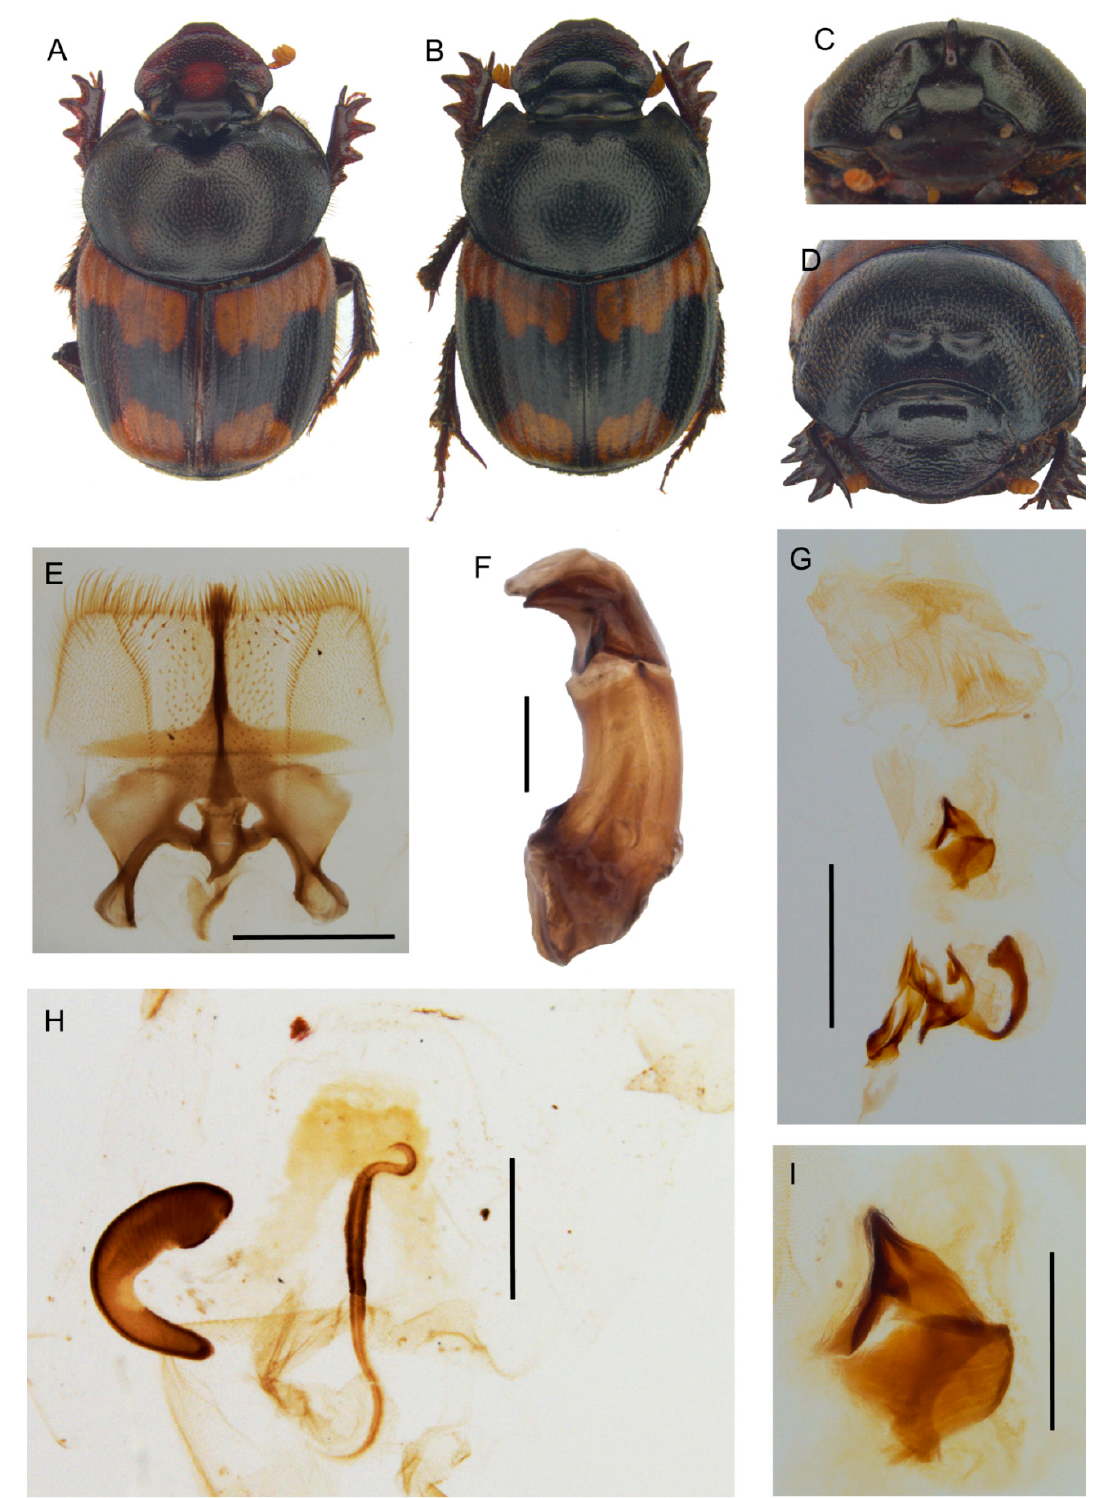
Figure 10. Features of Tiaronthophagus katanganus n.sp. (A) : Male facies (above). (B) : Female facies (above). (C) : Male facies (frontal view). (D) : Female facies (frontal view). (E) : Epipharynx, scalebar = 0.5 mm. (F) : Male genitalia, phallobase and parameres, scalebar = 0.5 mm. (G) : Male genitalia, endophallus, scalebar = 0.5 mm. (H) : Female genitalia, vagina and receptaculum seminis, scalebar = 0.5 mm. (I) : Male genitalia, lamella copulatrix, scalebar = 0.2 mm.